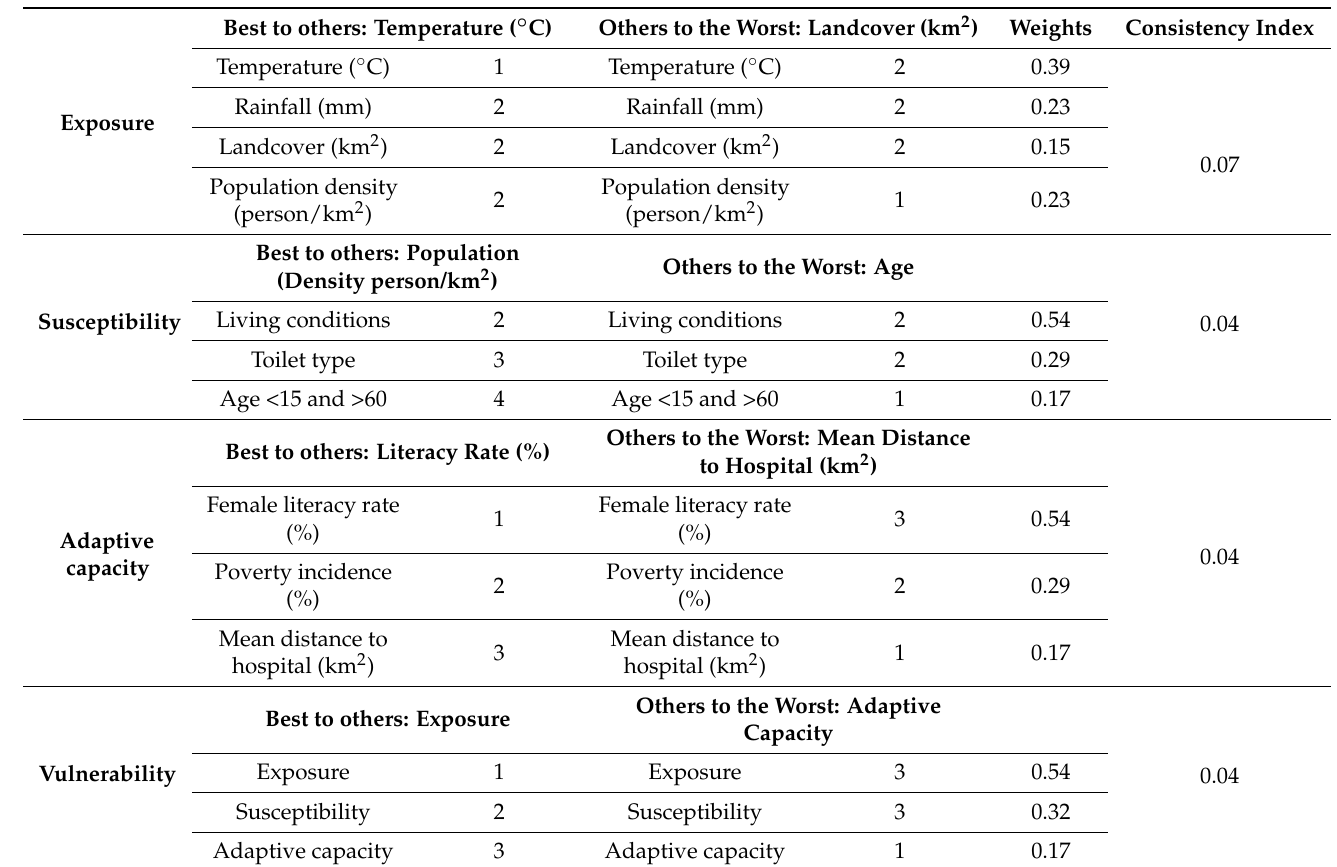
Table 3. Weight calculations of indicators using the Best-Worst Method